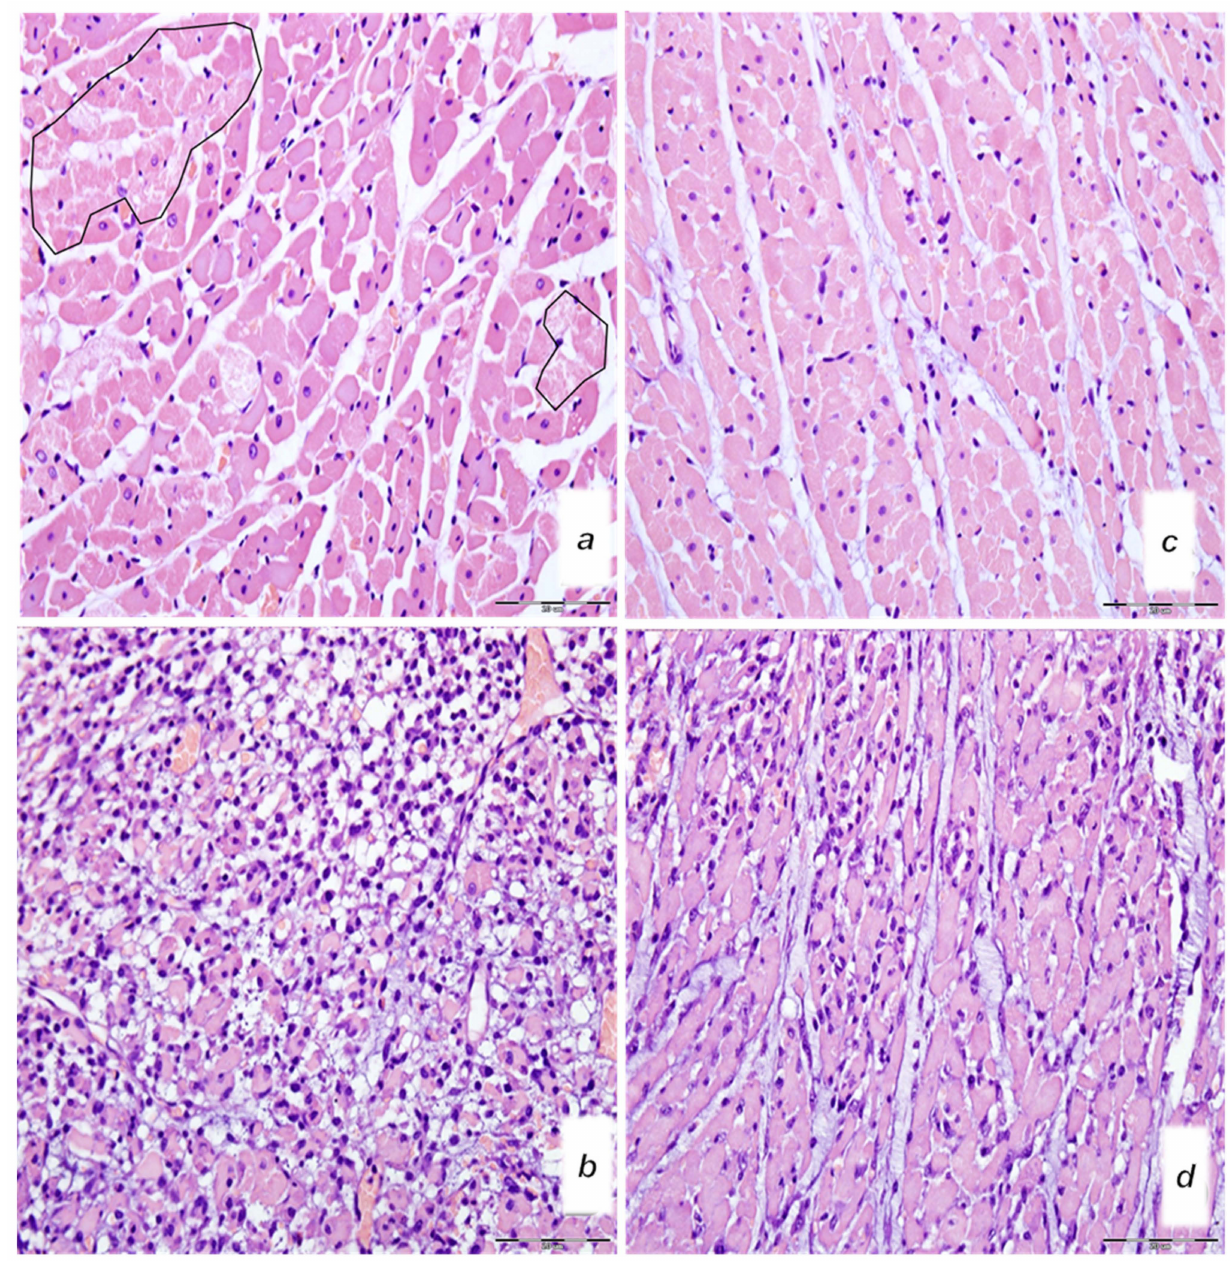
Figure 15. Microscopy presentation of heart injury. Rats challenged once with isoprenaline 150 mg/kg s.c., mediation at 30 min before isoprenaline ( a–d ). Upper 24 h. ( a , c ) Single and small groups of necrotic myocites without inflammation (irregular circles) (magnification 400 × , scale bar 20 µ m) (saline (5 mL/kg i.p, left)) ( a ); single and small groups of necrotic myocites without inflammation (magnification 400x, scale bar 20 µ m) (BPC 157 (10 µ g/kg i.p., right)) ( c ). Low ( b , d ). Pronounced inflammatory infiltrate with necrotic myocites (magnification 400 × , scale bar 20 µ m) (saline (5 mL/kg i.p, left)) ( b ). Moderate inflammatory infiltrate affecting up to half of the septal thickness (magnifica- tion 400 × , scale bar 20 µ m) (BPC 157 (10 µ g/kg i.p., right)). ( d ). (HE